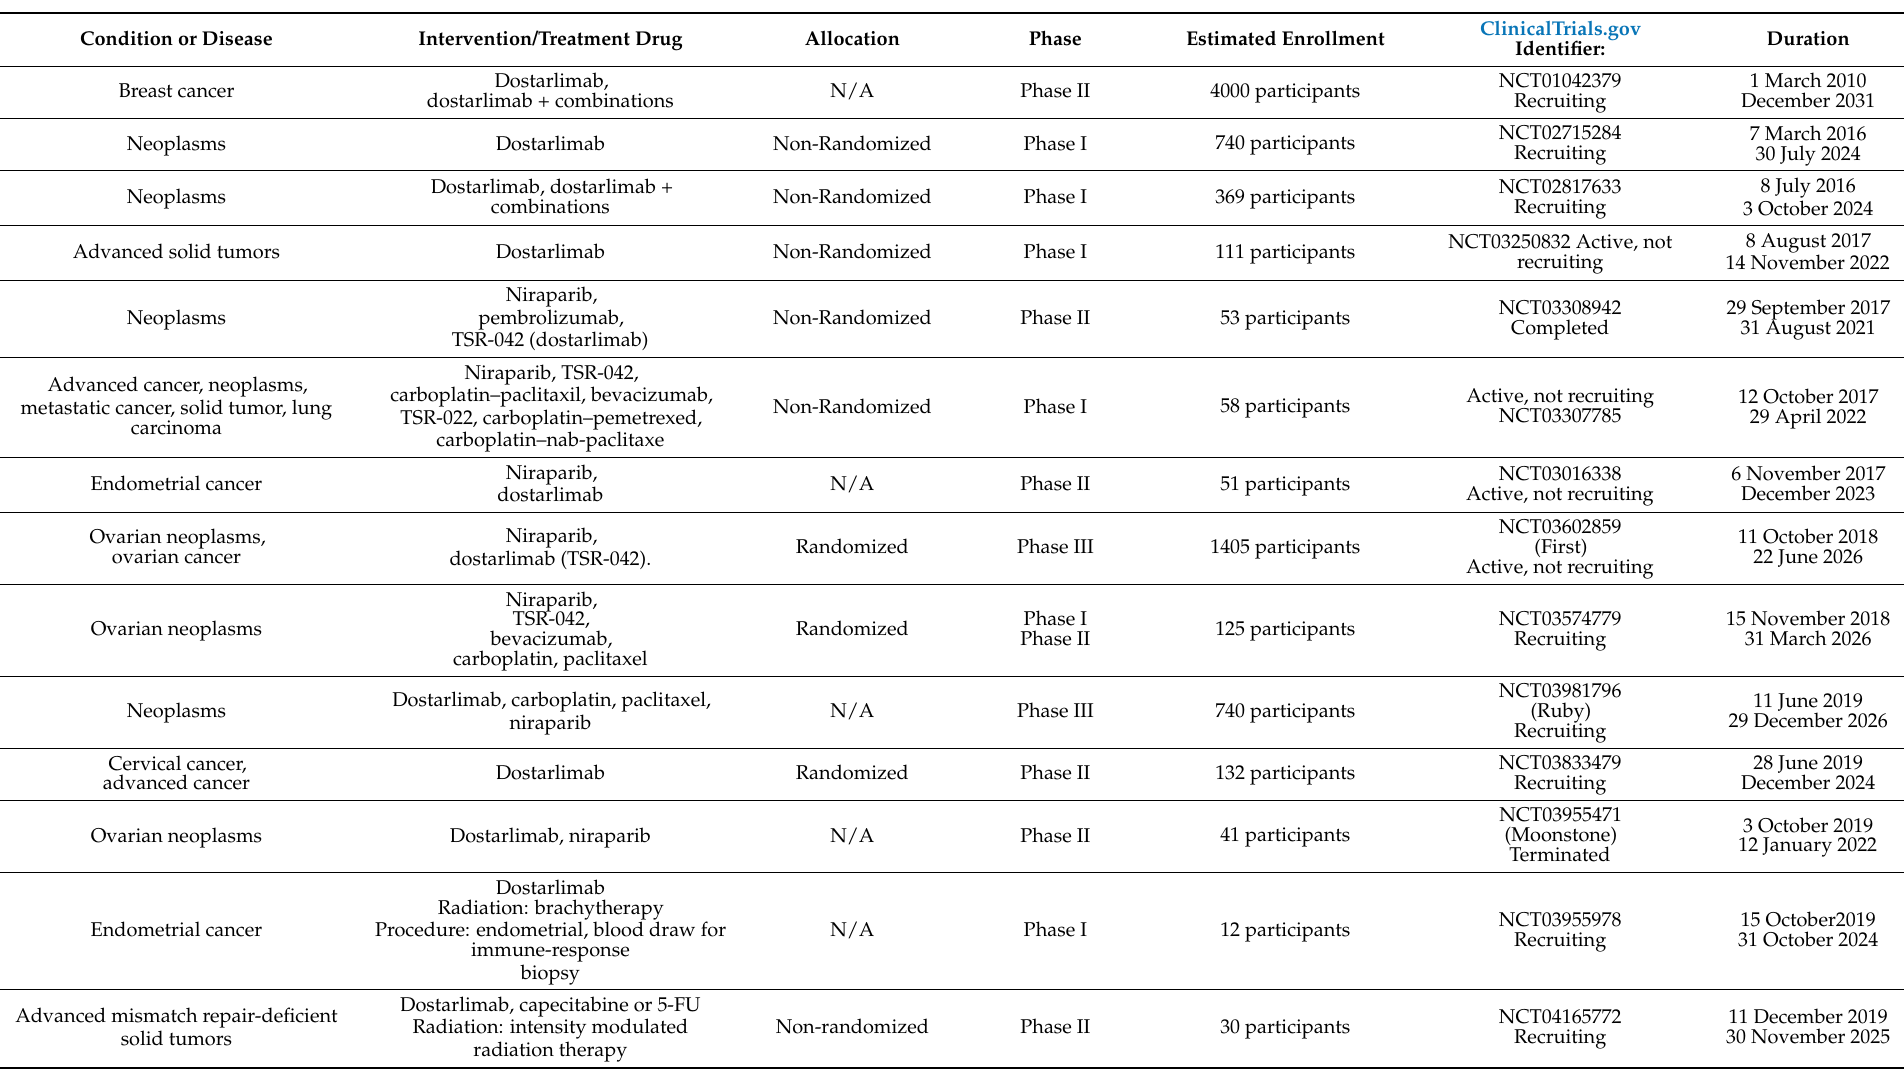
Table 2. Dostarlimab clinical trials alone and with other combinations until